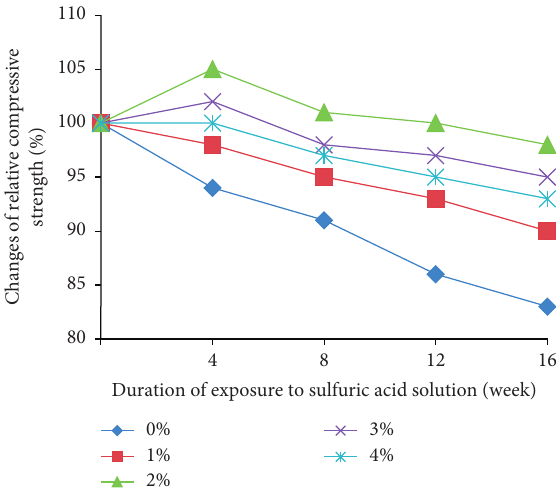
Figure 9: Relative weight changes of the concrete samples con- taining GO/Al 2 O 3 nanoparticles in sulfuric acid.